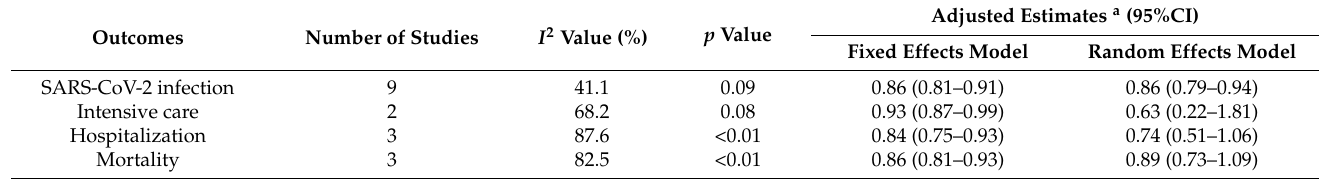
Table 3. Summary of the overall association between influenza vaccination and SARS-CoV-2 infection and clinical outcomes.